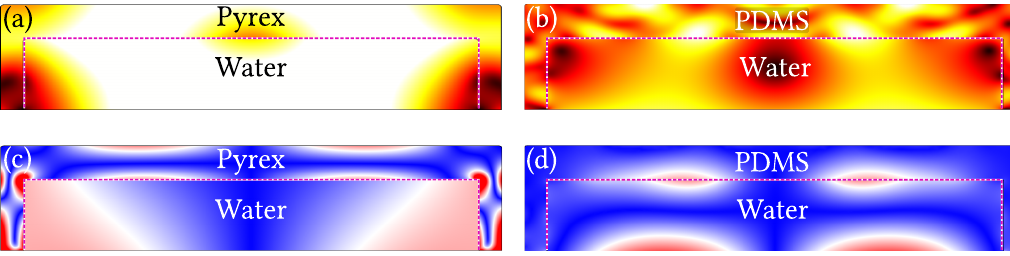
(cid:12) (cid:12) (cid:12) − i ω u s (cid:12) in the pyrex and (cid:12) (cid:12) (cid:12) p f (cid:12) / K PDMS using the bulk